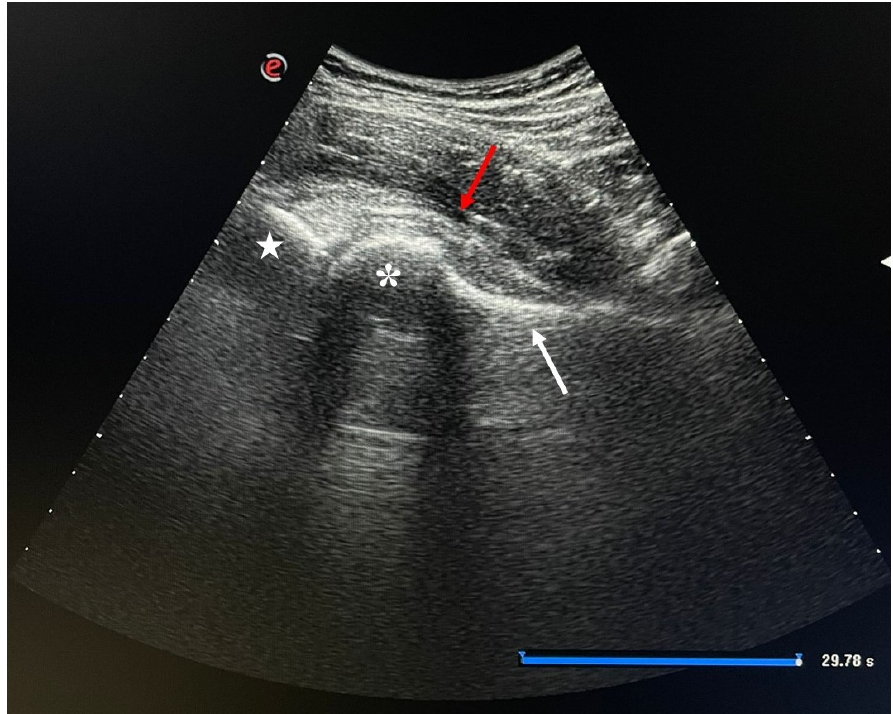
Figure 3. Ultrasound long-axis view of the hip as it is visualized during injection. Star = anterior rim of acetabulum; * = femoral head; white arrow = femoral neck; red arrow = joint capsule.